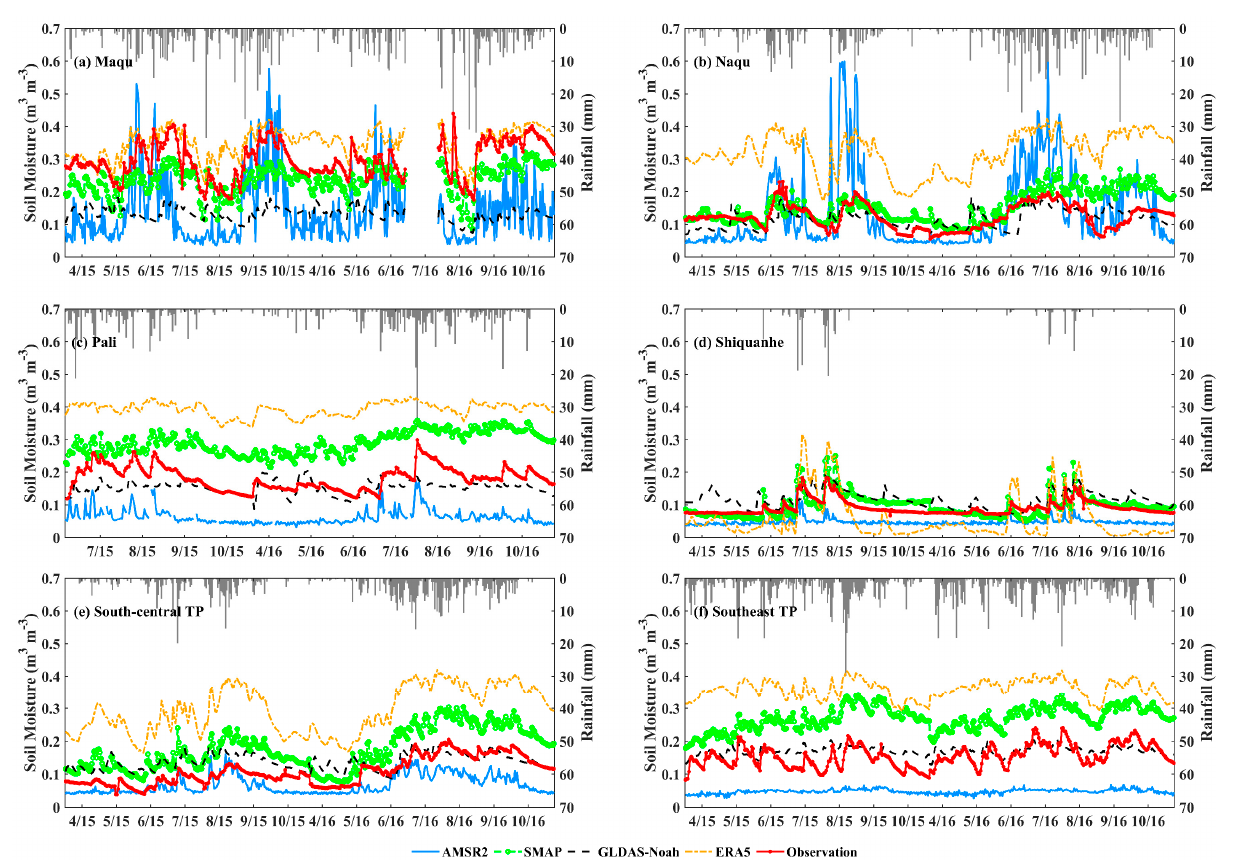
Figure 2. The time series for SM of in situ observations, AMSR2, SMAP, GLDAS-Noah, ERA5, and the in situ observed rainfall in April–October from 2015 to 2016 in different TP regions.